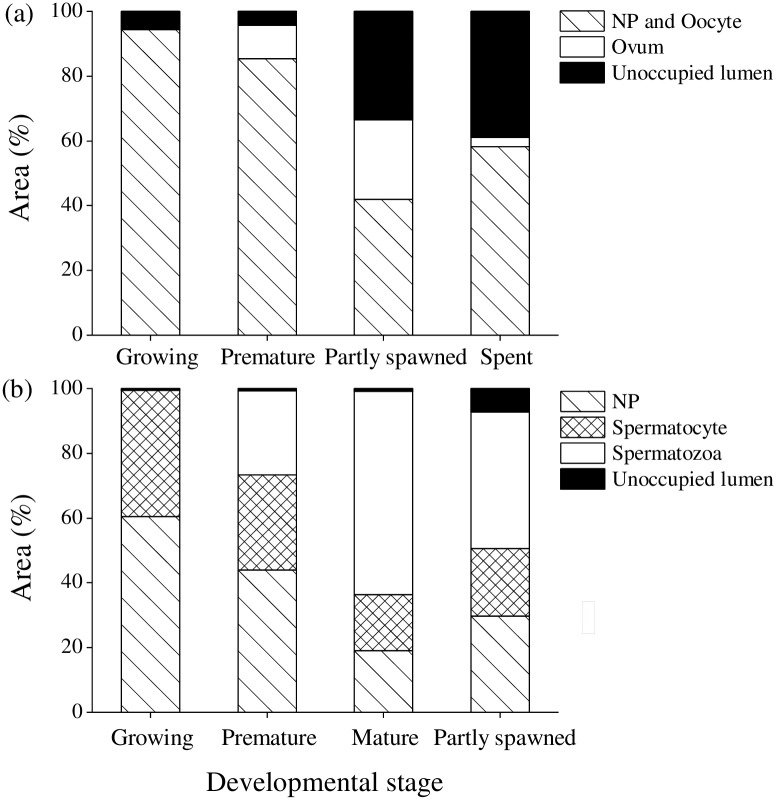
Percentage area of acinar components of female (n = 38) and male (n = 27) Heliocidaris crassispina at different gonad developmental stages.(a) Acinar component in ovary: nutritive phagocytes (NPs), oocytes, ovum, unoccupied lumen. (b) Acinar component in testis: NPs, spermatocytes, spermatozoa, unoccupied lumen. Urchins were collected in August 2014.